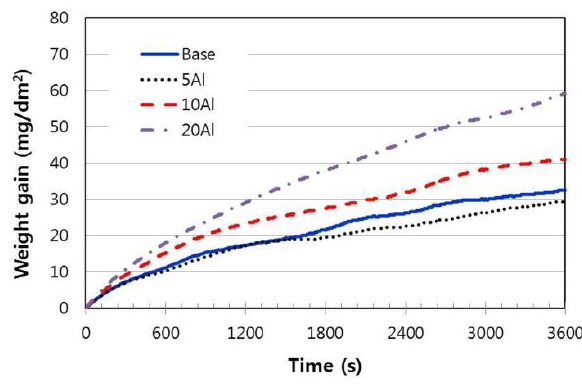
Figure 7. Oxidation behavior of Cr–xAl–5%Si alloys during the isothermal heating at 1100 °C.